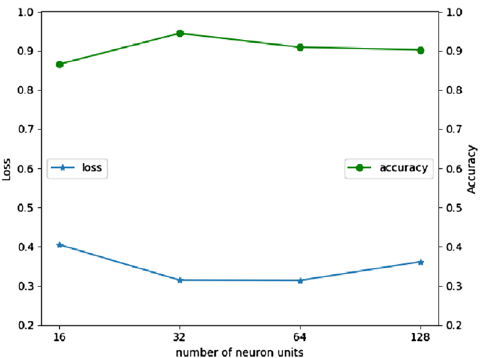
Figure 11. The accuracy and loss comparation with different neuron units.